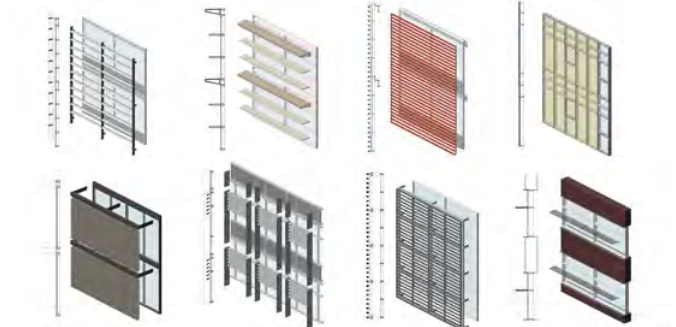
Figure 9. ShadingsTypes (payette.com)